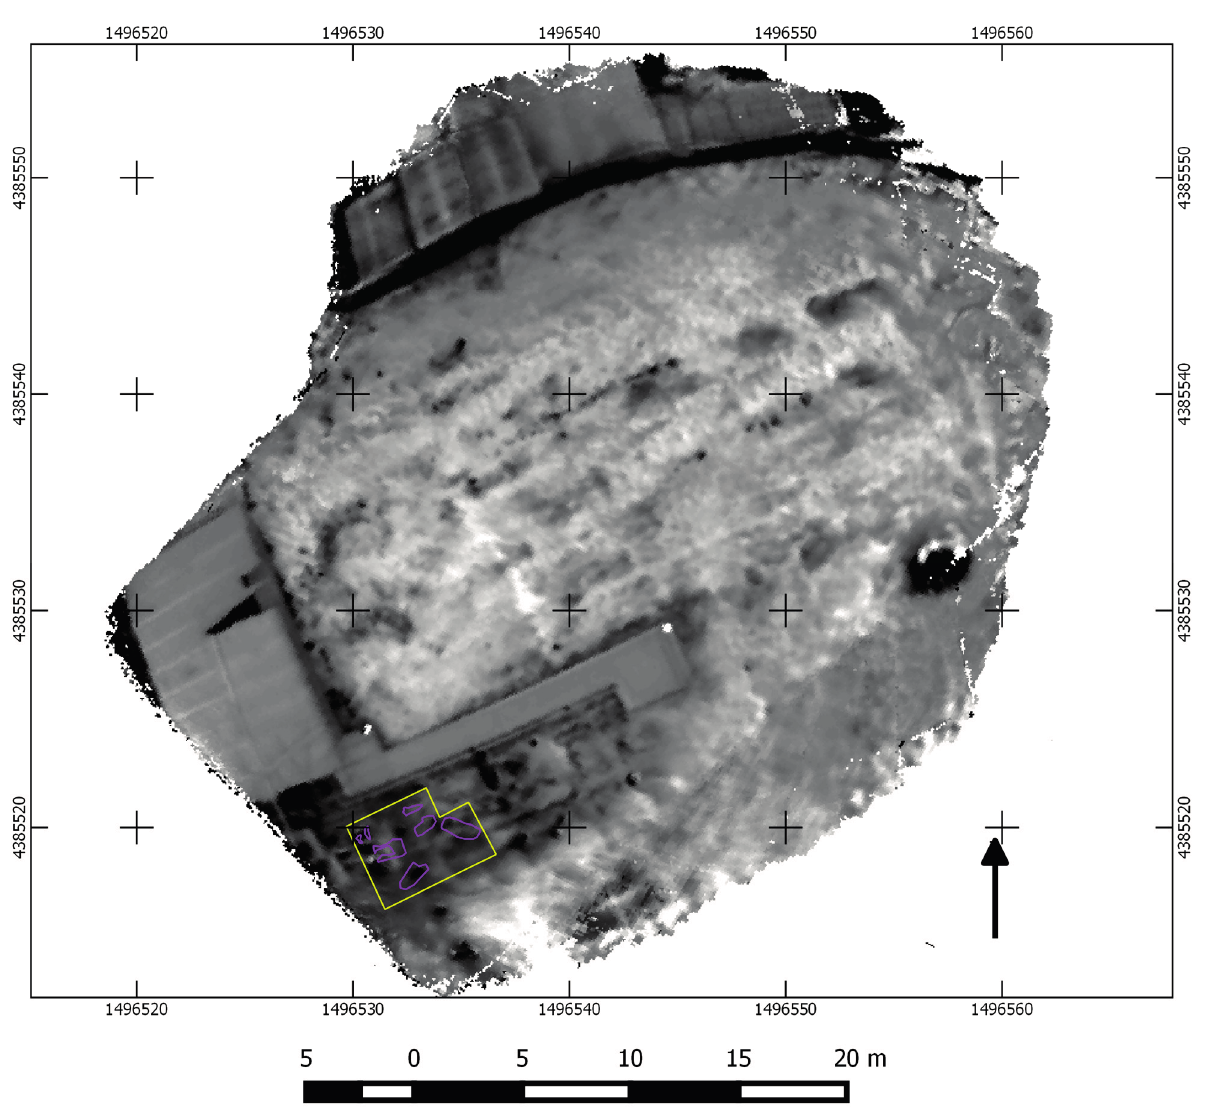
Figure 16. Map obtained by multiplying normalized intercept temperature by normalized NTG maps (both centered on the mean value). Positive values are darker, while negative ones are brighter. In the south-western part of the map, the border of the most recent digging area is indicated in yellow, while dug (after the survey) tombs are in